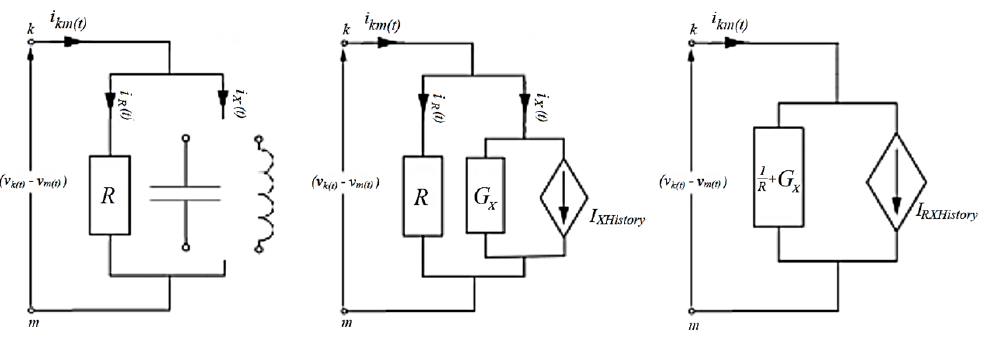
Figure 7. Parallel RI/RC Branch